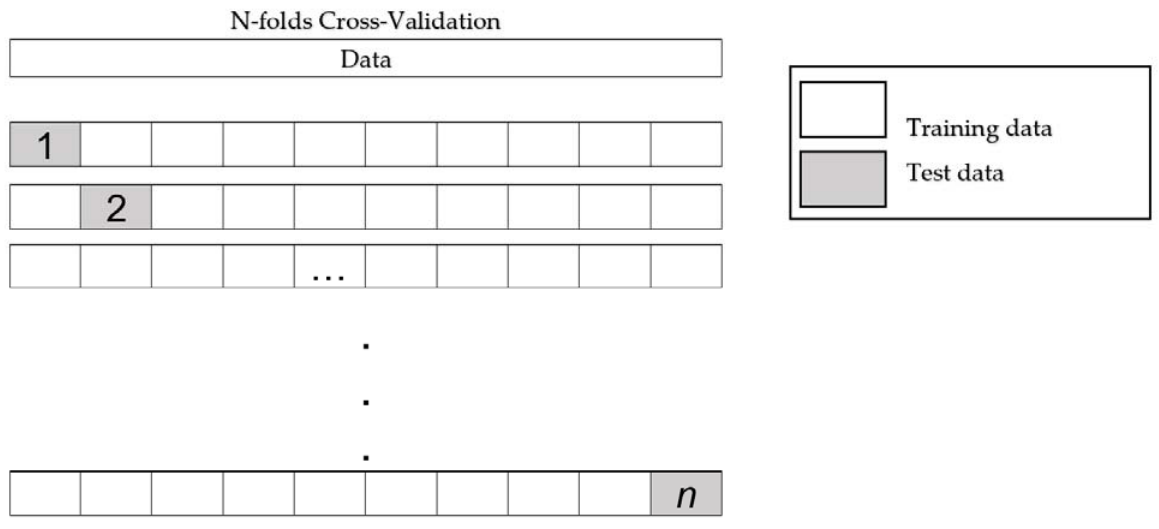
Figure 3. Scheme of N -fold cross-validation.